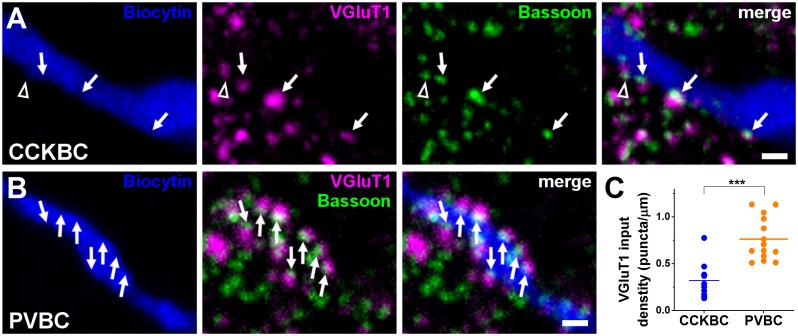
Parvalbumin-containing basket cells (PVBCs) receive a higher number of excitatory inputs than cholecystokinin-expressing basket cells (CCKBCs).VGluT1-immunopositive puncta opposing the dendrite of a CCKBC (A) and a PVBC (B) and containing bassoon staining were regarded as a contact (arrows). Open arrowhead shows a vesicular glutamate transporter 1 (VGluT1)-immunoreactive bouton in which bassoon didn't oppose the biocytin-labeled dendrite, presumably contacting a neighboring structure. Scale: 1 μm. (C) Each data point on the plot represents an average density obtained on a dendritic segment, lines represent mean. Biocytin-labeled dendritic segments of 5 CCKBCs and 6 PVBCs were investigated. (CCKBC: 0.32 ± 0.06, PVBC: 0.76 ± 0.06, Mann–Whitney U test, ***p < 0.001) (S4 Data).